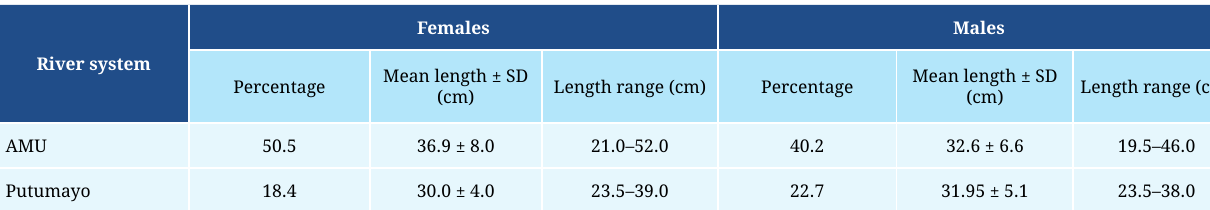
TABLE 4 | Percentage, standard length mean ± standard deviation (SD) and ranges of immature females and males of Pseudoplatystoma punctifer in the AMU system and Putumayo